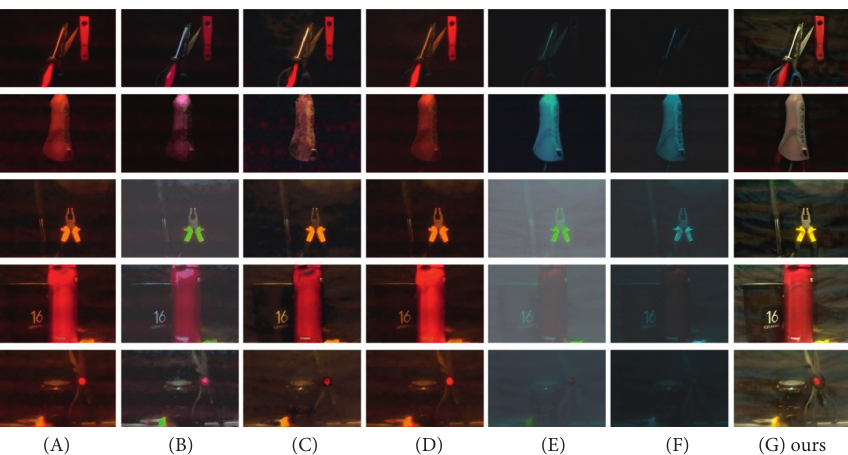
Figure 12: The testing comparison between our algorithm and the method based on deep learning. The columns from A to H, respectively, represent S+D +type 1 UWCNN model (A), S +D+ type 7 model (B), S+D +type I (C), S+ D+type III (D), by type7 from original image (E), type 9 model (F), and by our algorithm (G).